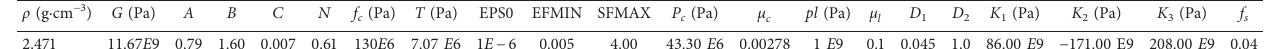
Table 3: The material parameters of HJC [36].